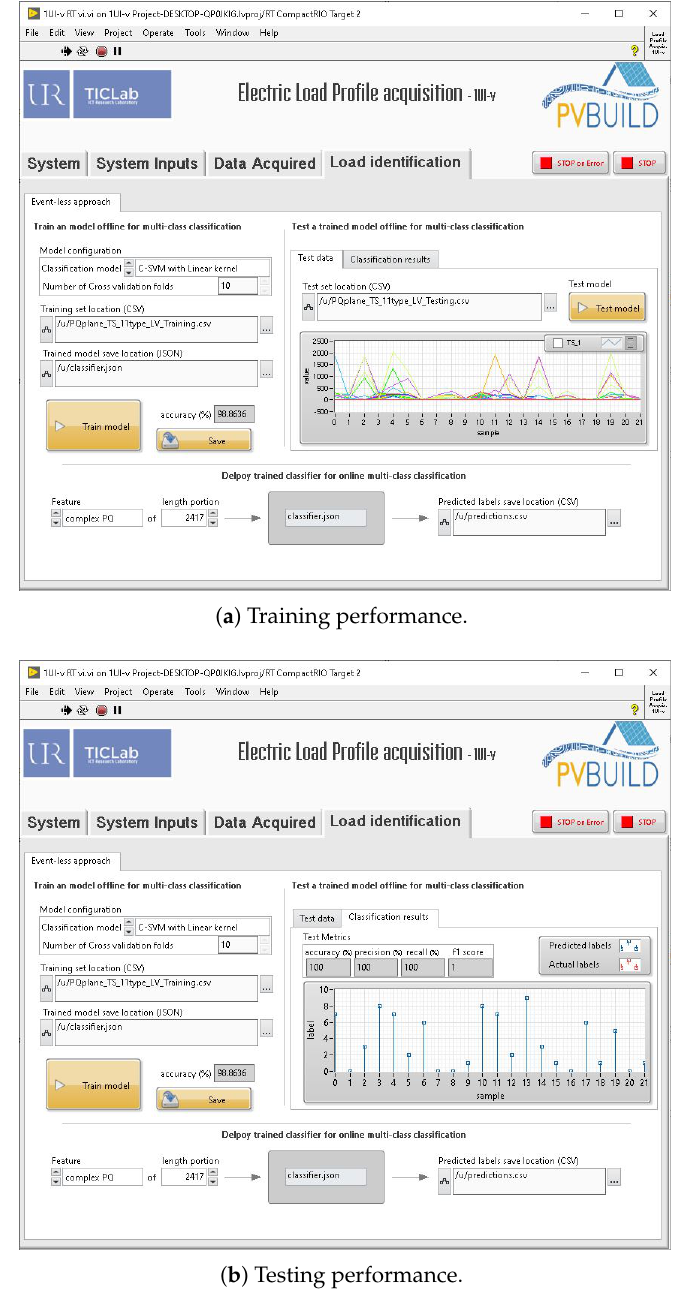
Figure 17. Training and testing of the Support Vector Machine (SVM) model for multi-class